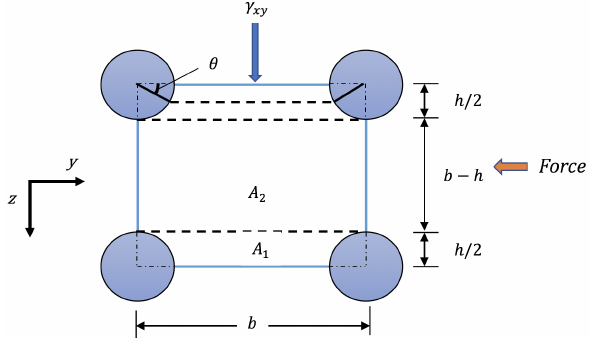
Figure 3: Distortion of the unit cell generated by strain in the xy plane ( 𝛾 xy ); b is the distance between the adjacent fibers and h is